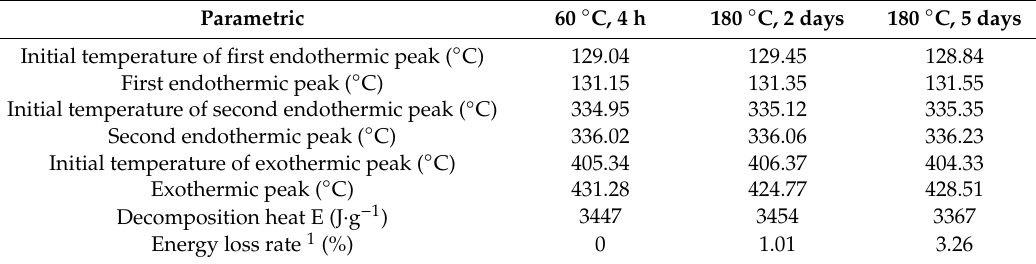
Figure 7. DSC curves of 4#BPN 60 °C,4 h samples and 180 °C samples (heating rate 5 °C/min). Table 5. DSC parameter comparison of 4#BPN sample (°C) (heating rate 5 °C/min).